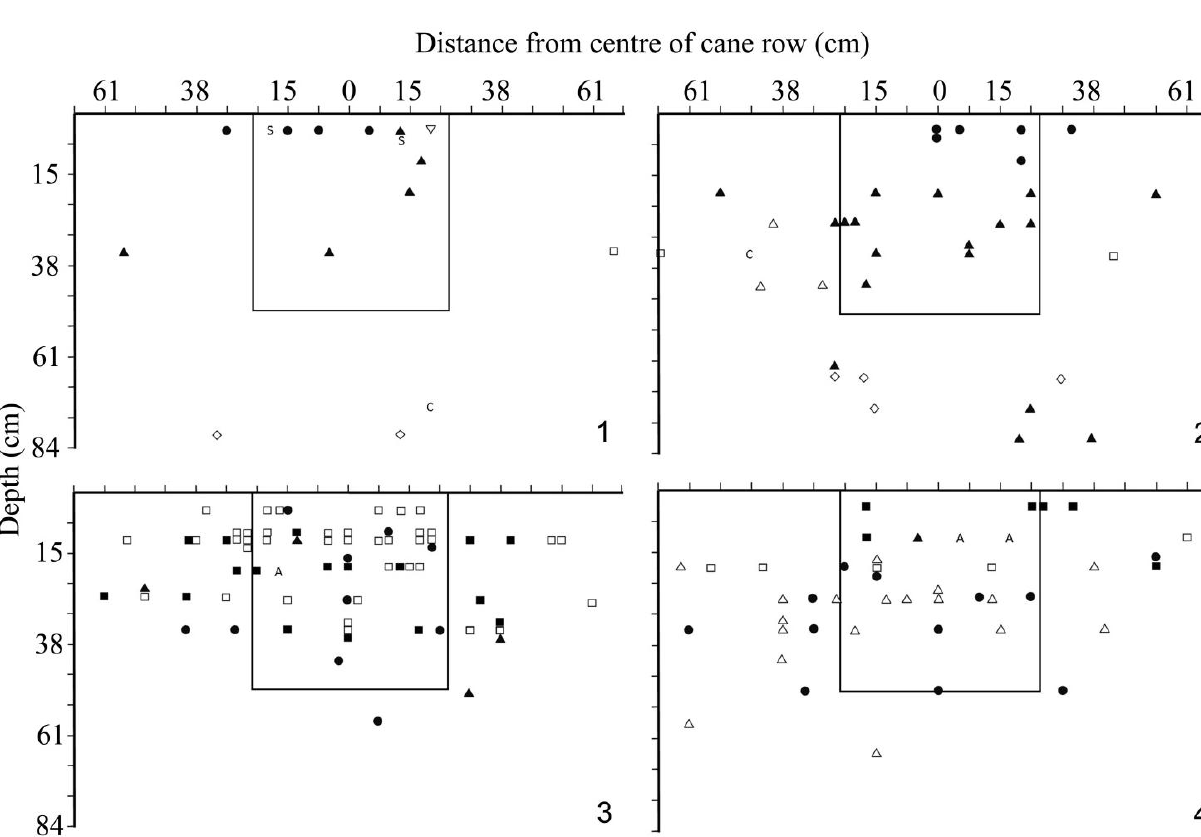
Figure 5. Transects of the cane row to show the distribution of white grub larvae and adults in the soil, JSP, October 1986. The cross section sampled with the normal 0.5 × 0.5 × 0.5 cm pit is indicated by the square. 1 , 2 , KN06/10; 3 , 4 , (cid:47)(cid:54)(cid:20)(cid:19)(cid:18)(cid:19)(cid:28)(cid:17)(cid:3)(cid:46)(cid:72)(cid:92)(cid:29)(cid:3)(cid:404)(cid:3) Cochliotis melolonthoides L3 (Figures 5.1, 2) or Brachylepis werneri (cid:11)(cid:41)(cid:76)(cid:74)(cid:88)(cid:85)(cid:72)(cid:86)(cid:3)(cid:24)(cid:17)(cid:22)(cid:15)(cid:3)(cid:23)(cid:12)(cid:30)(cid:3)(cid:374)(cid:15)(cid:3)(cid:401)(cid:3)(cid:34) Triodontella sp. A (larva B), L3, (cid:47)(cid:21)(cid:15)(cid:3)(cid:47)(cid:20)(cid:30)(cid:3)(cid:376)(cid:15)(cid:3) (cid:204) ? Schizonycha (cid:86)(cid:83)(cid:17)(cid:3)(cid:11)(cid:79)(cid:68)(cid:85)(cid:89)(cid:68)(cid:3)(cid:38)(cid:12)(cid:3)(cid:34)(cid:47)(cid:22)(cid:15)(cid:3)(cid:34)(cid:47)(cid:21)(cid:30)(cid:3)(cid:184)(cid:15)(cid:3)(cid:88)(cid:81)(cid:78)(cid:81)(cid:82)(cid:90)(cid:81)(cid:3)(cid:38)(cid:72)(cid:87)(cid:82)(cid:81)(cid:76)(cid:76)(cid:81)(cid:68)(cid:72)(cid:3) sp. (larva E) ?L2;